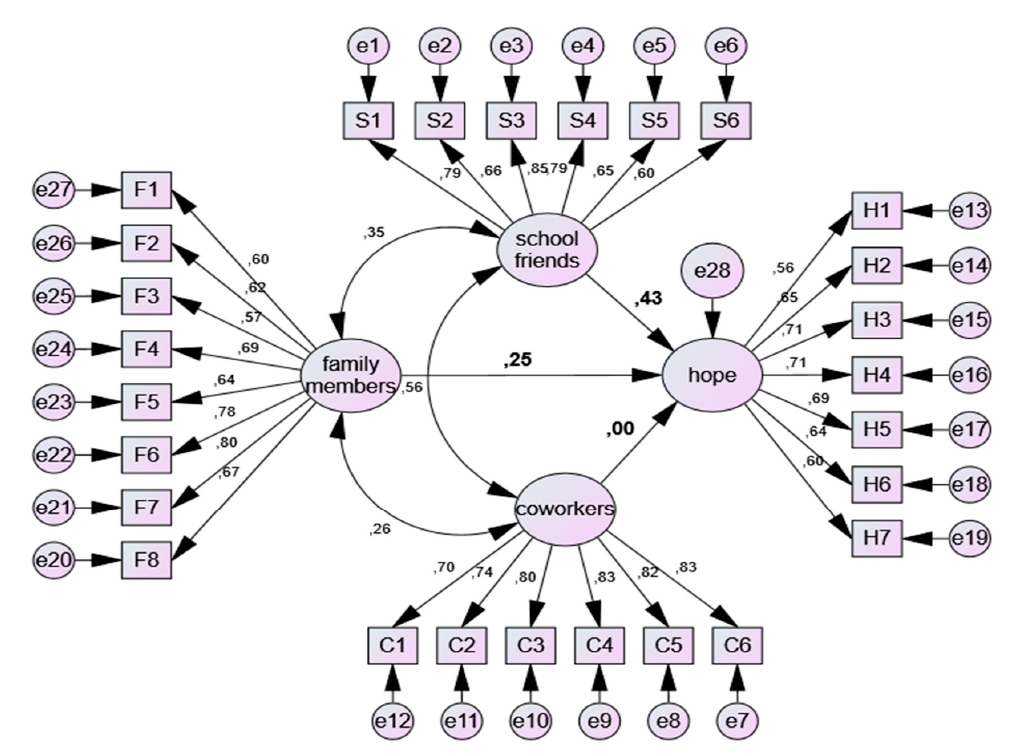
Figure 2. Structural Equation Model output.